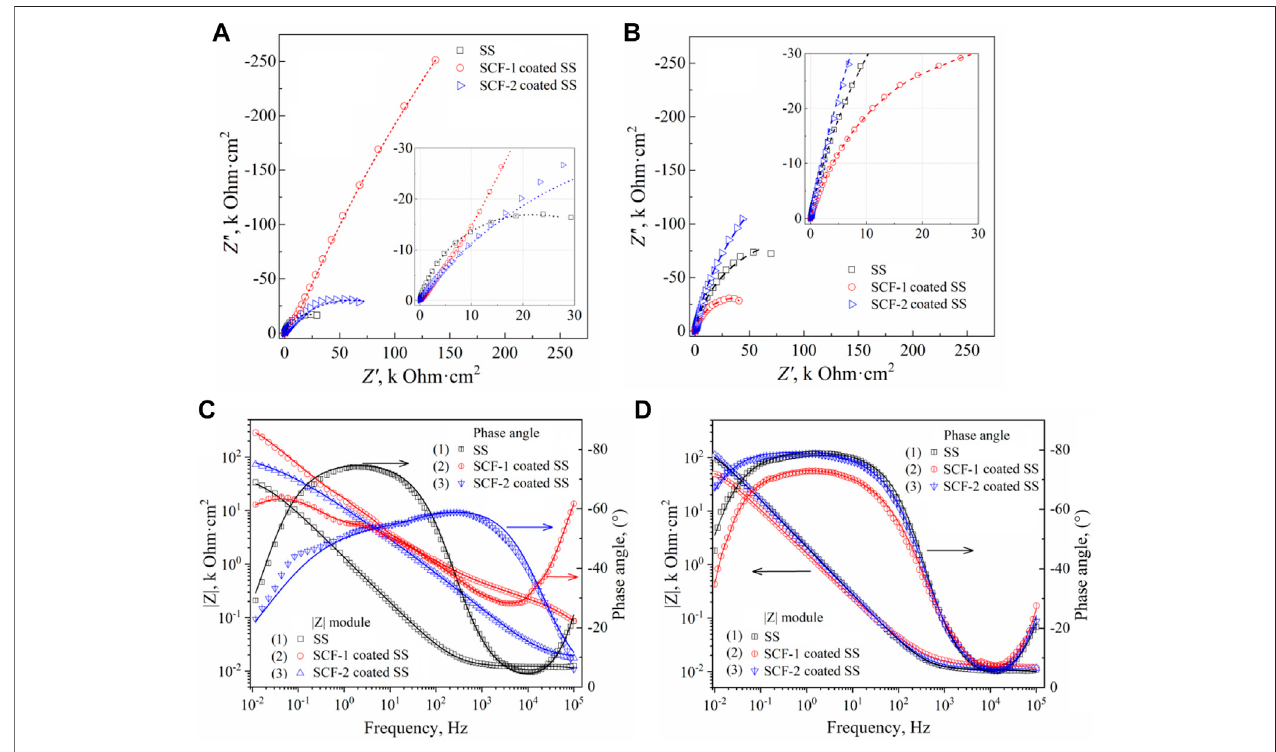
FIGURE 11 | EIS results of the BG-ESM-PCL composite coatings in SBF solution. Nyquist plots at a) 1 h (A) and 40 h (B) of immersion, and Bode plots at 1 h (C) and 40 h (D) of immersion.